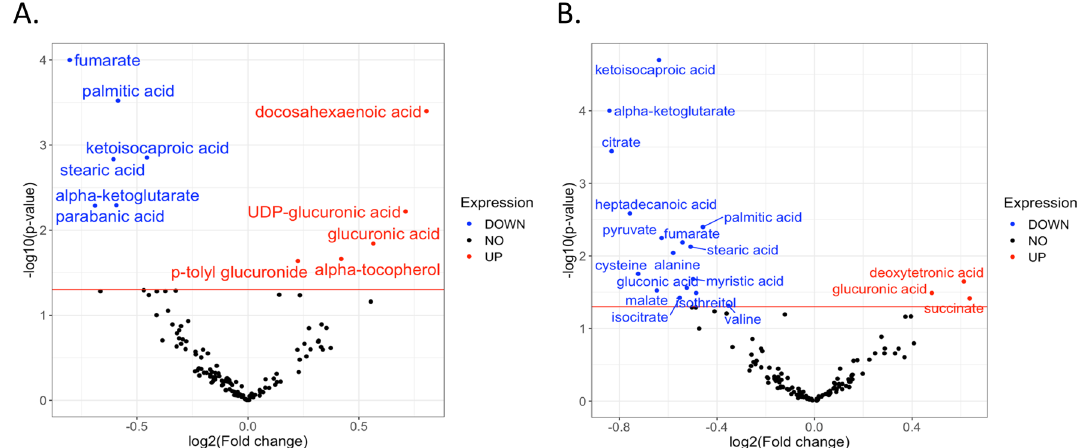
Figure 2. Volcano plots of changes in primary metabolites, relative to baseline, after EPA ( a ) and DHA ( b ) supplementation. Metabolites are shown in red if significantly increased following supplementation and in blue if significantly reduced following supplementation. Red line represents the cut-off point for FDR < 0.05.